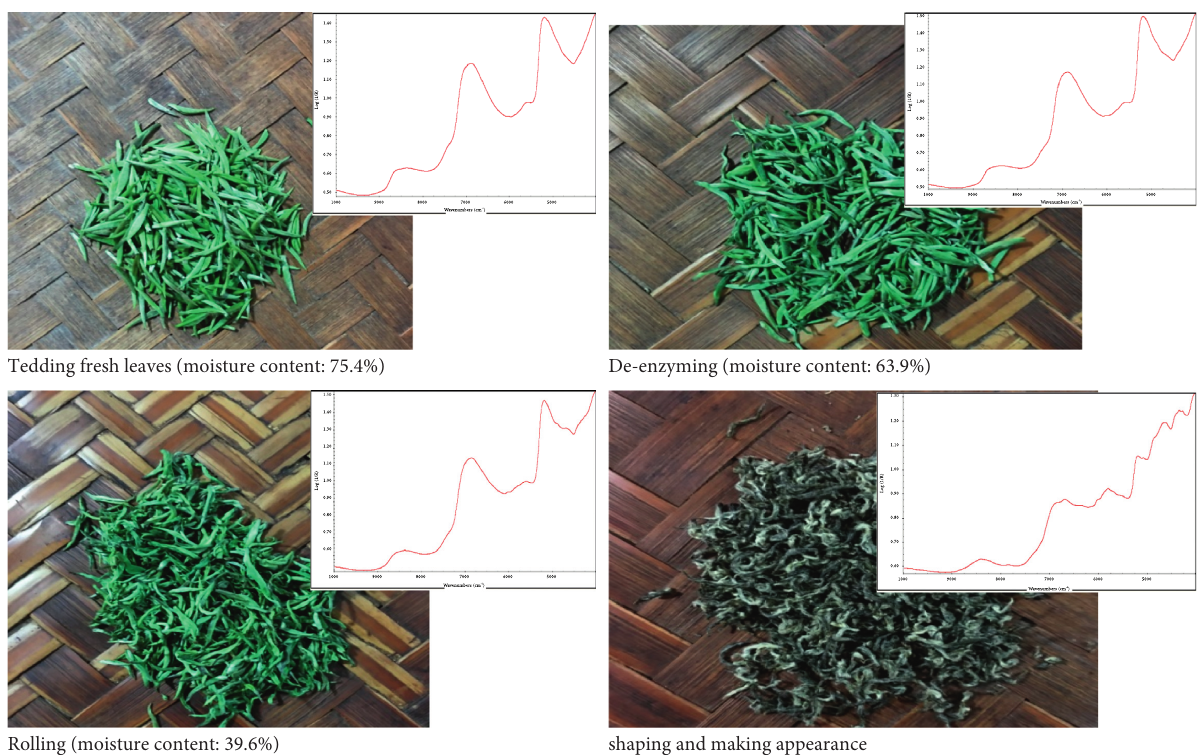
Figure 2: Moisture content changes in the tea production